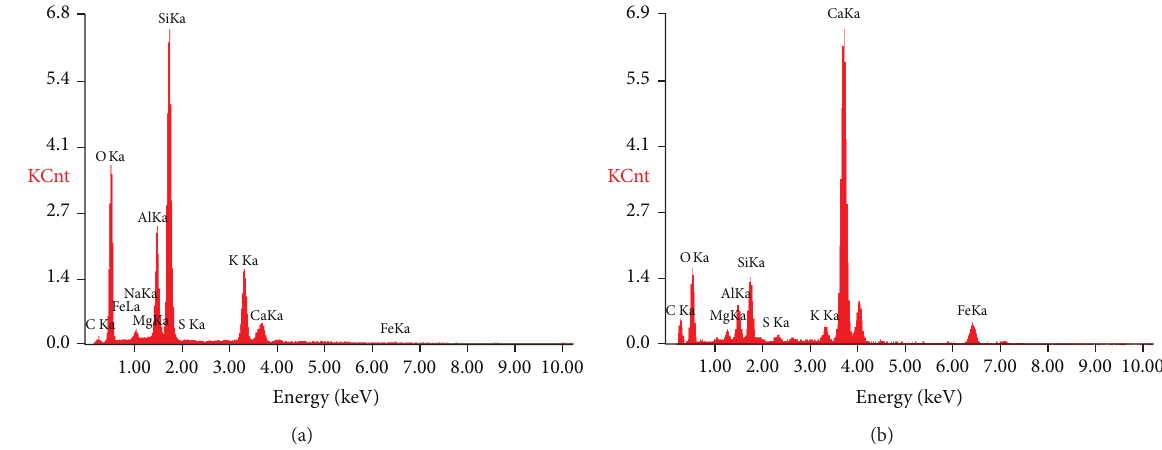
Figure 9: EDS analysis on concrete with PVA at different hydration ages: 3 days (a) and 28 days (b).